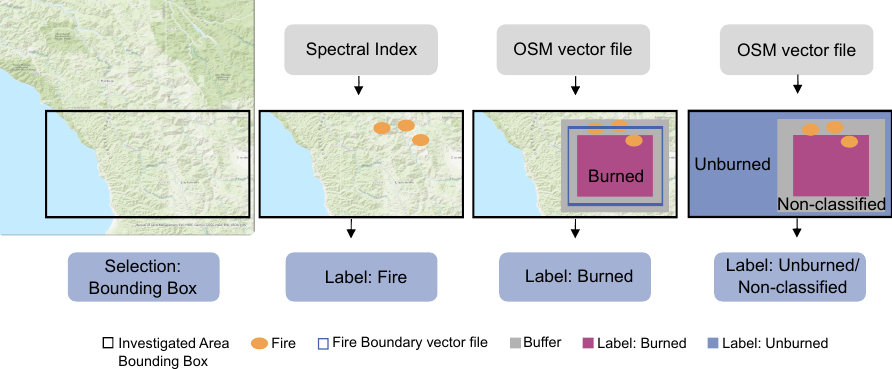
Figure 3. Visualization of Steps 1 to 4 of the reference generation. Base map: ESRI ArcGIS Pro. Projection: